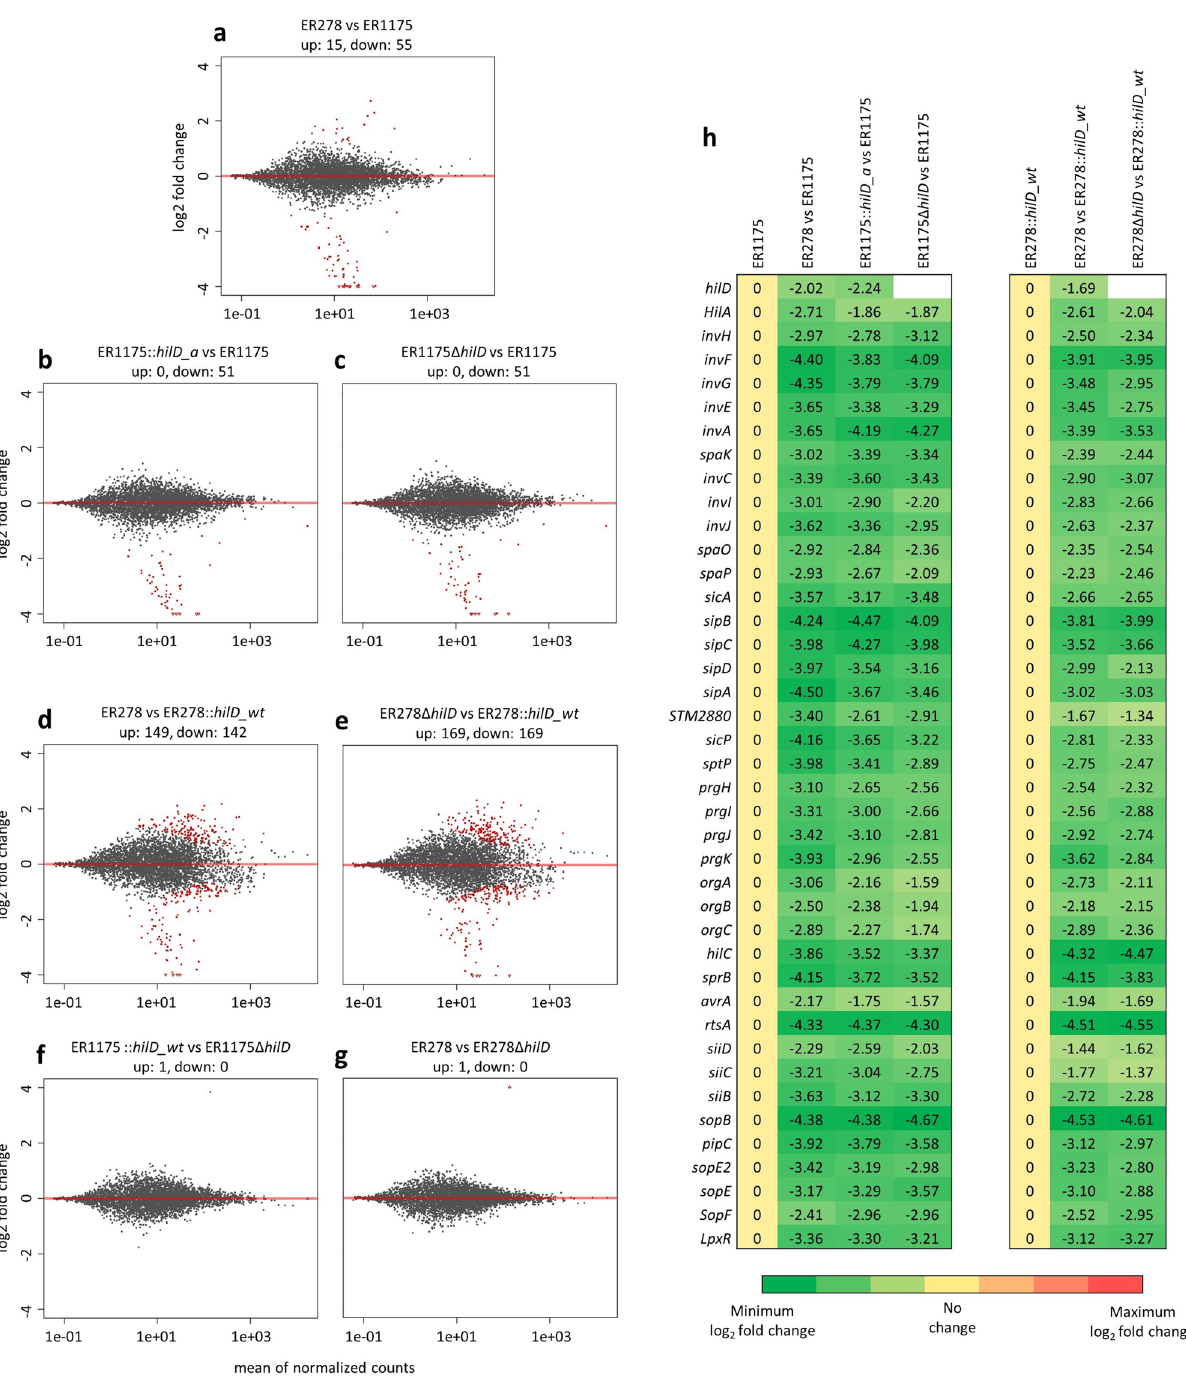
Figure 4. Comparative transcriptome analysis. ( a – g ) MA-plots. The gene expression log2 fold change for each comparison is plotted on the y-axis and the average of the counts normalized by size factor is shown on the x-axis. Each gene is represented by a dot. Genes with an adjusted p-value below the threshold (0.05) are shown in red. The number of up and down-regulated genes in each comparison is specified above the corresponding MA-plot. ( h ) List of genes significantly downregulated in strains carrying hilD_a or deleted for hilD compared to the same strains carrying hilD_wt . For each gene, name and log2 fold change are